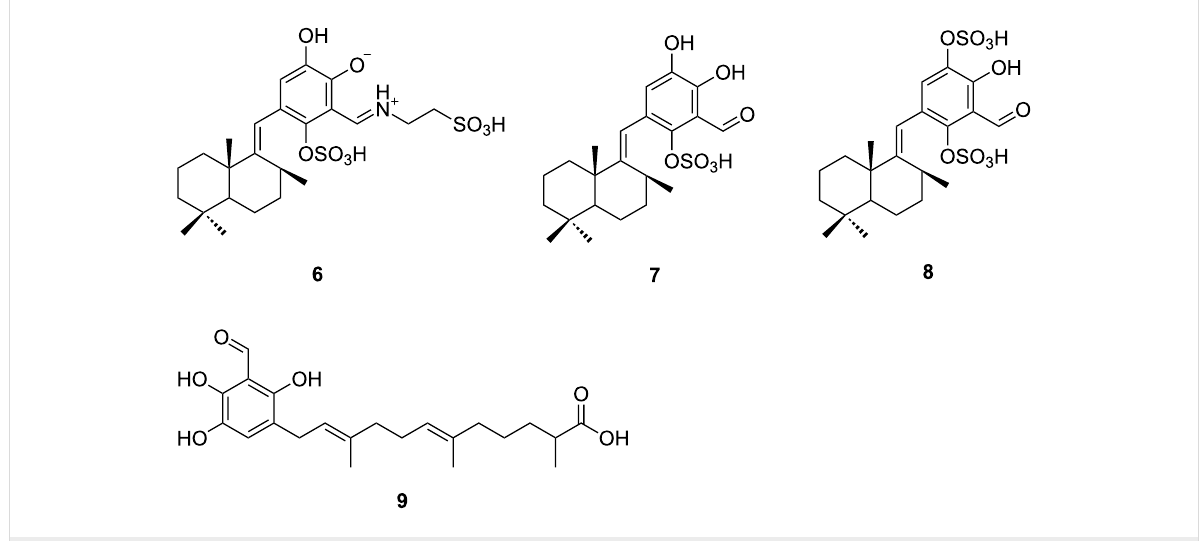
Figure 2: Structures of the related known compounds siphonodictyal B1 ( 6 ), siphonodictyal B2 ( 7 ), siphonodictyal B3 ( 8 ), and siphonodictyal E ( 9 ) from the sponge Aka coralliphagum .